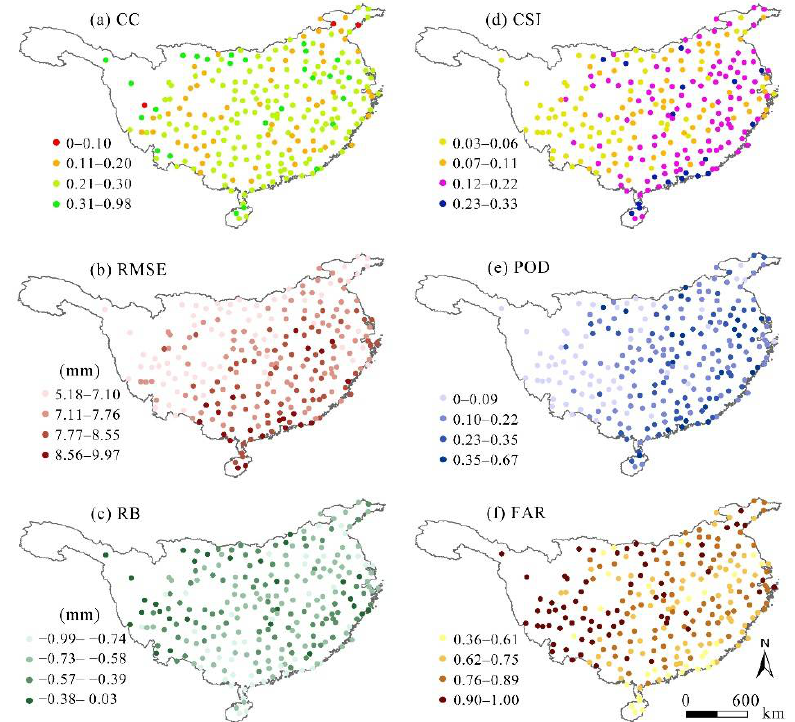
Figure 3. The spatial distribution of IMERG LR statistical indices (( a ) CC, ( b ) RMSE, and ( c ) RB) and categorical indices (( d ) CSI, ( e ) POD, and ( f ) FAR).